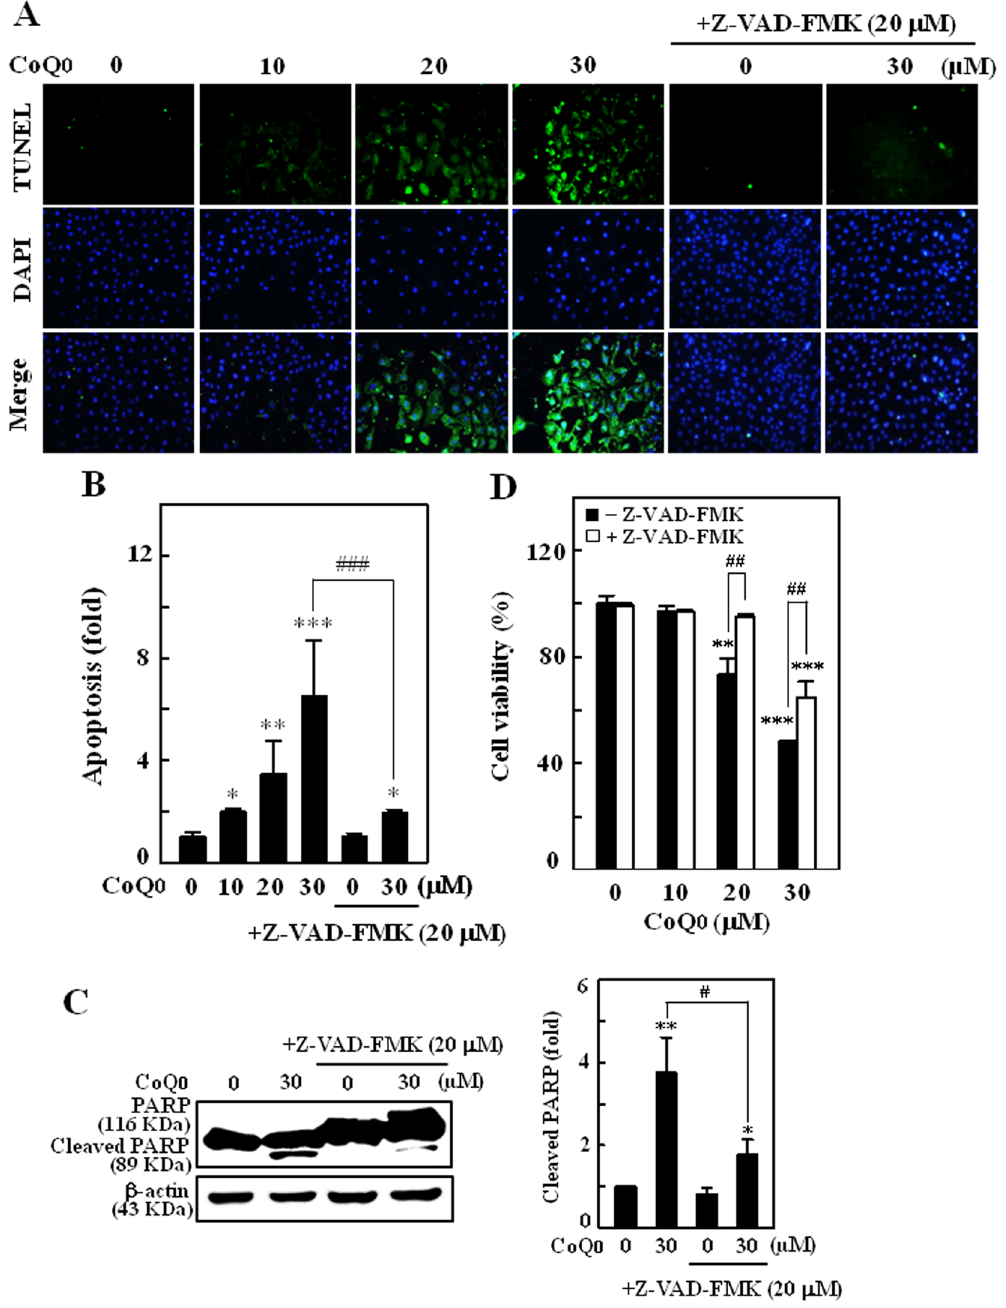
Figure 5. CoQ 0 triggers apoptotic DNA fragmentation and promote death of SKOV-3 cells. ( A–D ) Cells were pretreated with caspase inhibitor (Z-VAD-FMK, 20 μ M) for 1 h followed by CoQ 0 (0–30 µ M) for 24 h. (A) Apoptotic DNA fragmentation was determined by TUNEL assay. The green florescence indicates TUNEL- positive cells in the microscopic fields (200 × magnification) from three separate samples. (B) The fold of apoptotic cells was calculated by quantifying the florescence intensity using commercially available software. (C) Cleavage of PARP was estimated by Western blot. Changes in protein intensities were quantified by commercially available software. (D) Cell viability with or without Z-VAD-FMK treatment was determined by MTT assay. Values expressed as mean ± SD of three independent assays (n = 3). Significant at * p < 0.05; ** p < 0.01; *** p < 0.001 compared with untreated control, and significant at ## p < 0.01; ### p < 0.001 compared with CoQ 0 alone treated